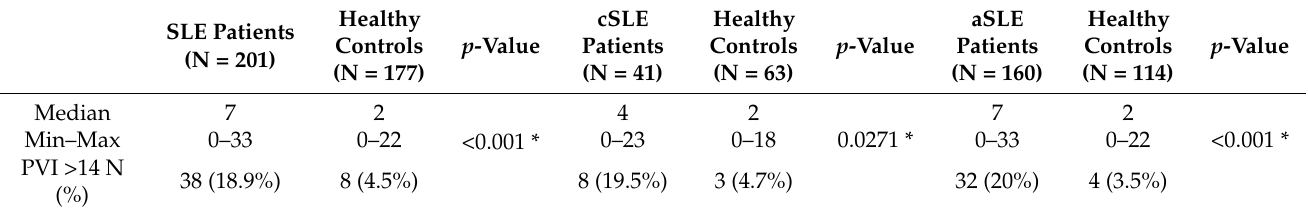
Table 6. Descriptive analysis of the PVI of all participants in each Ped-ANAM subtest (N =